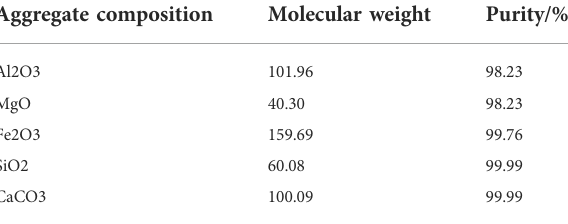
TABLE 1 Properties of the as-purchased aggregate material powders. Aggregate composition